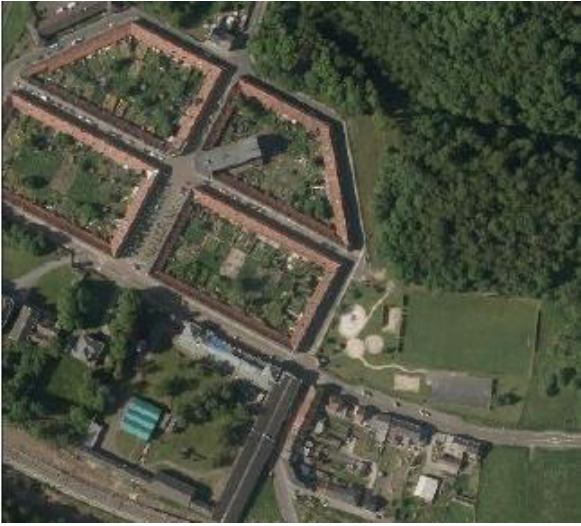
Figure 4: Screenshot of one of the generated orthophotos A series of topographic measurements is also performed on some of the workers residences. The coordinates of the